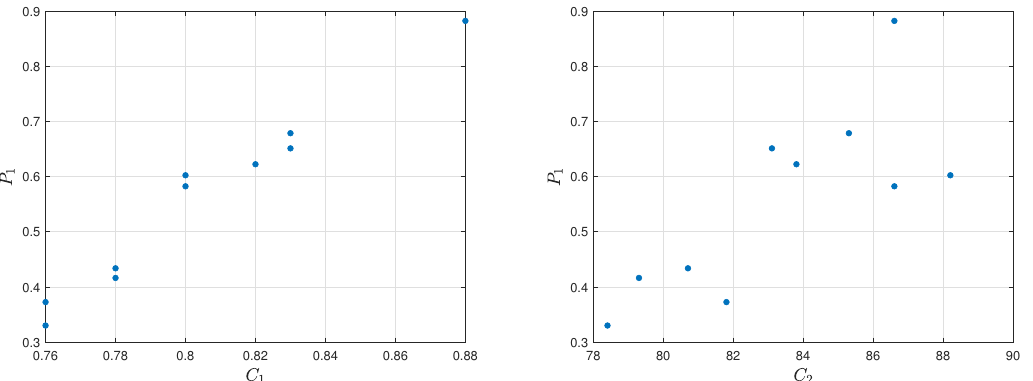
Figure 7. The relation diagram of Average kills per round ( C 1 ) for assessment P 1 ( left side ) and Average damage per round ( C 2 ) for assessment P 1 ( right side